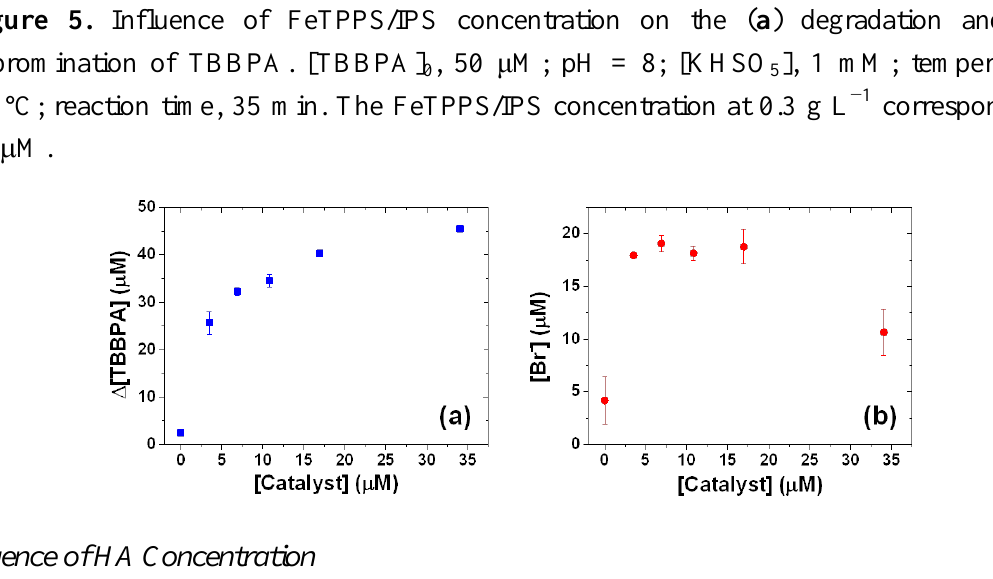
, 50 μM; pH = 8; [KHSO ], 1 mM; temperature, 0 5